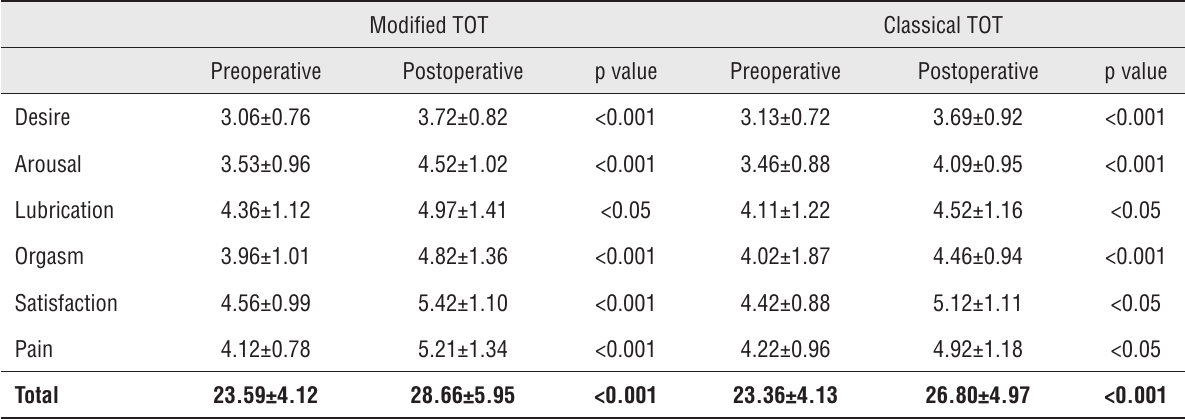
Table 3 - Changes between preoperative and postoperative scores on the FSFI.